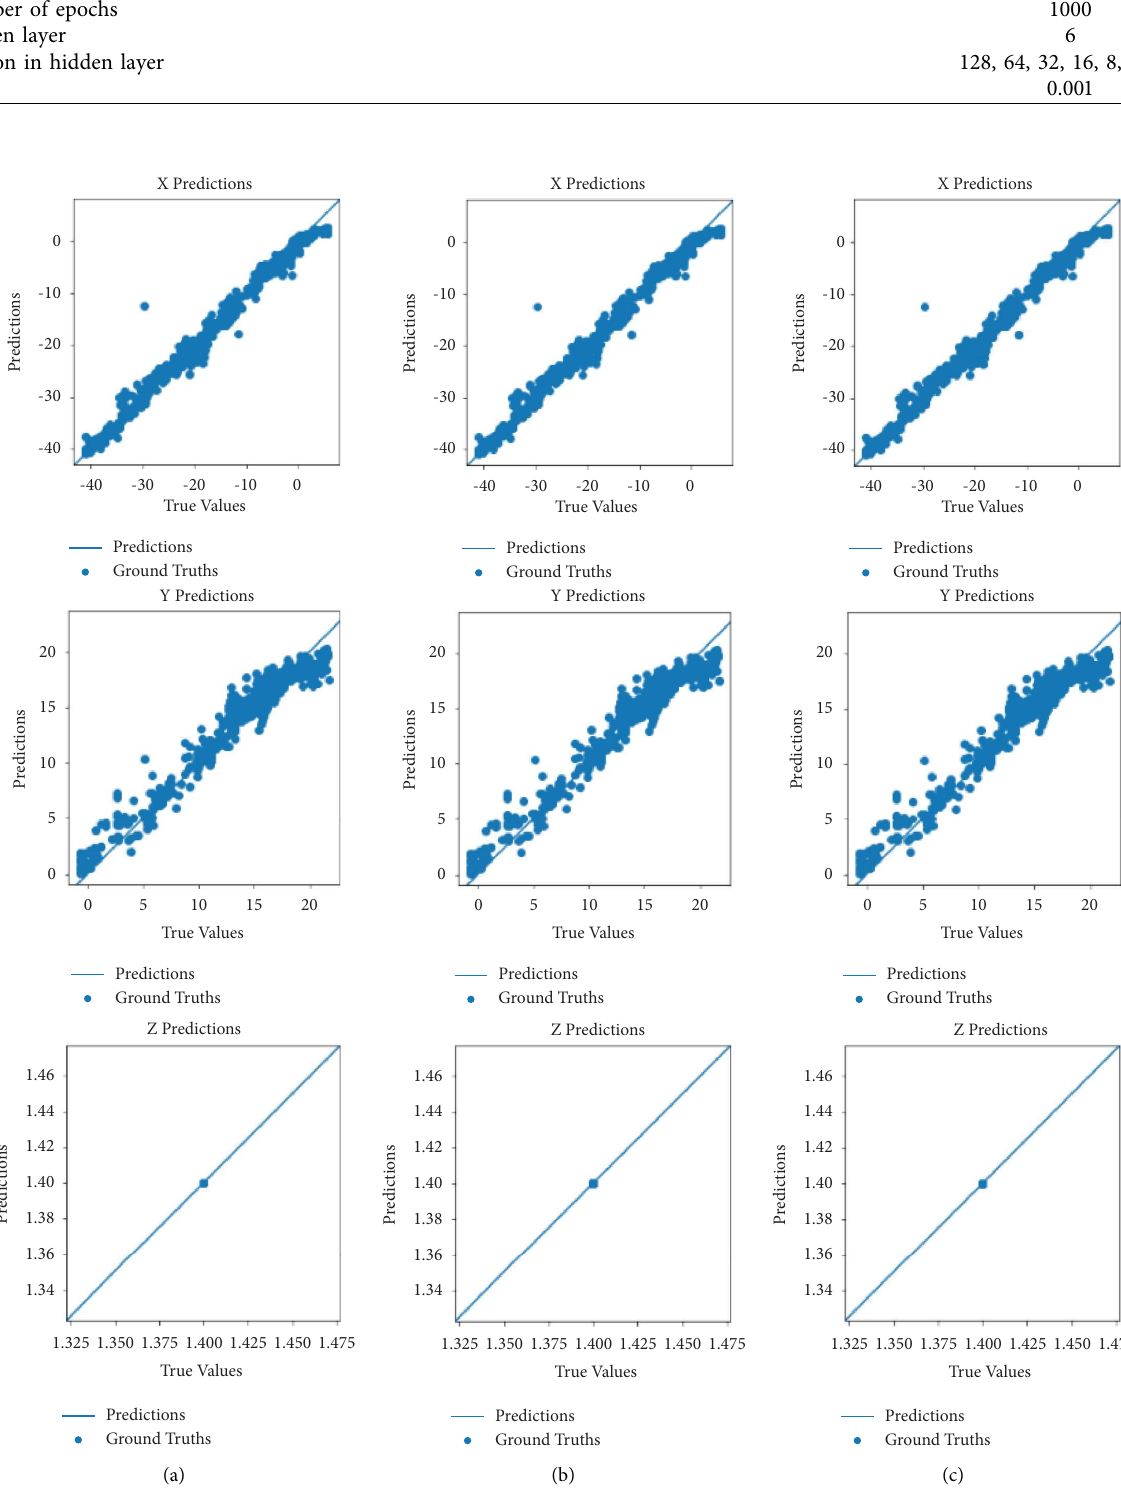
Figure 4: WKNN predictions (a) 1 AP pair, (b) 2–10 AP pairs, and (c) 1–10 AP